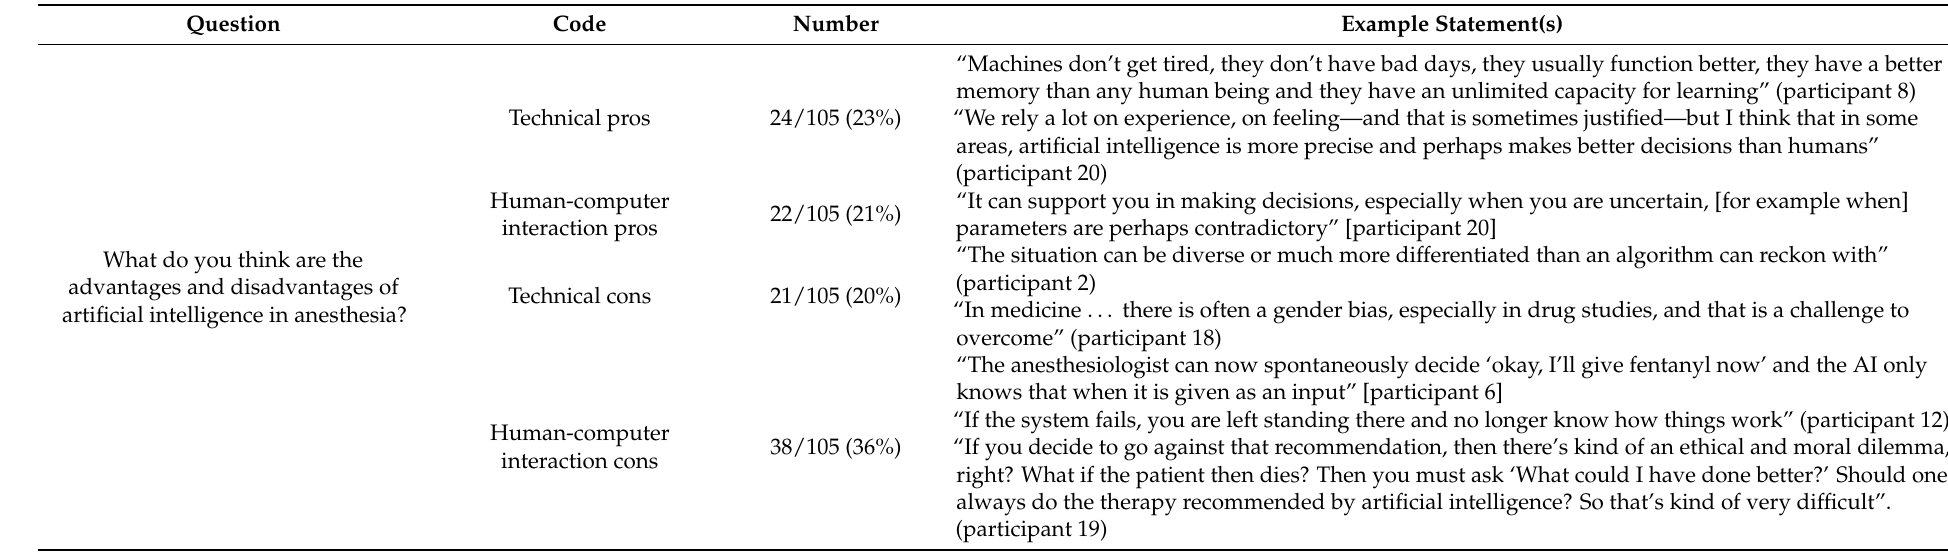
Table 3. An overview of responses to question 3, demonstrating a balanced view of the pros and cons of AI as applied to anesthesia, with example statements. Values are number